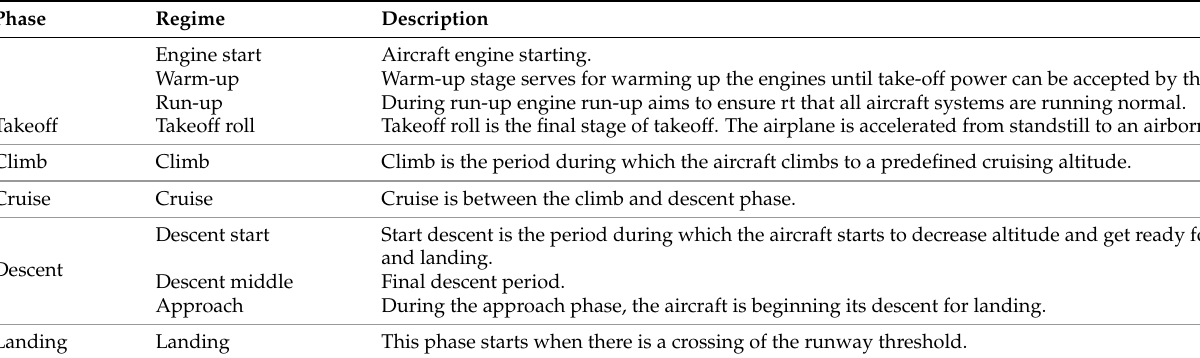
Table 1. Operational regimes.